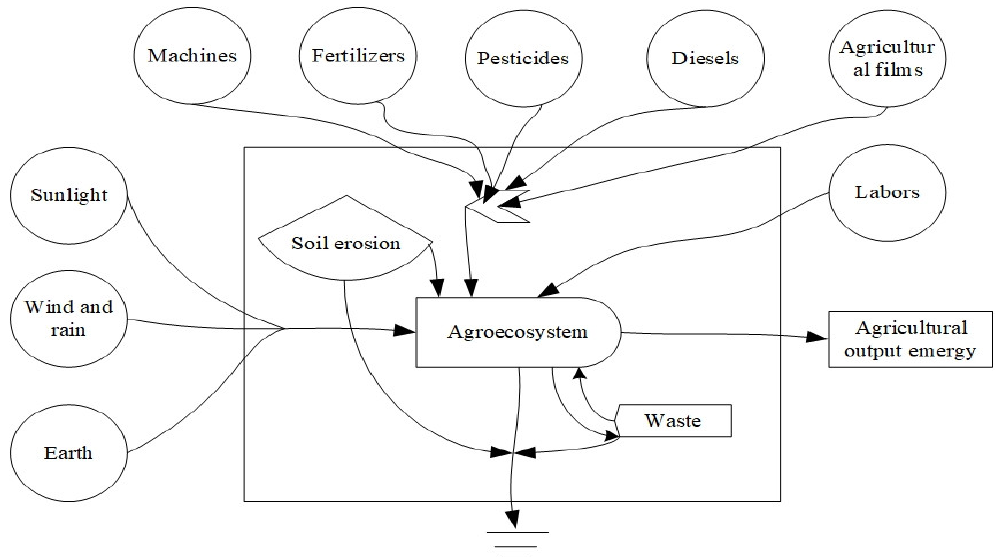
Figure 1. Emergy system diagram of the agricultural system.